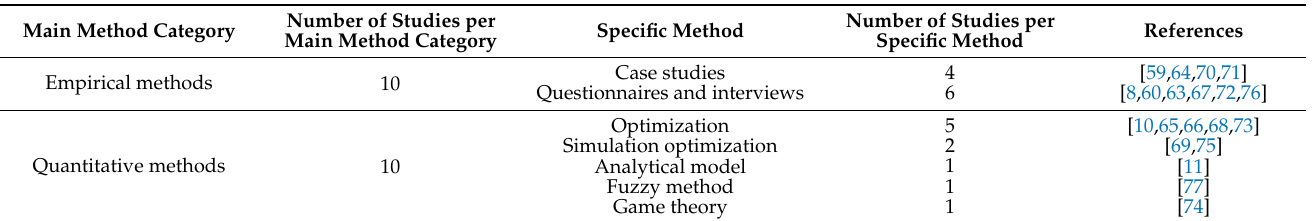
Table 9. Classification of studies on COVID-19-related strategies based on research